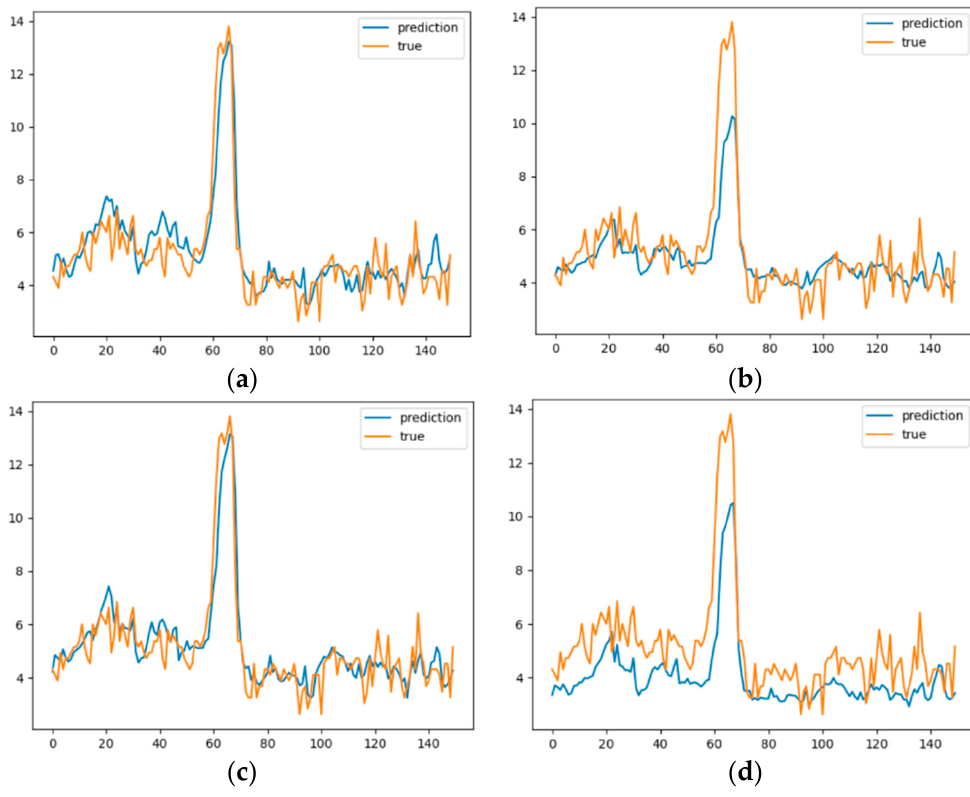
Figure 6. Fi tt ing trends of the di ff erent models. ( a ) LSTM; ( b ) ARIMA; ( c ) SVR; ( d ) HDL-learning. Figure 6. Fitting trends of the different models. ( a ) LSTM; ( b ) ARIMA; ( c ) SVR; ( d )